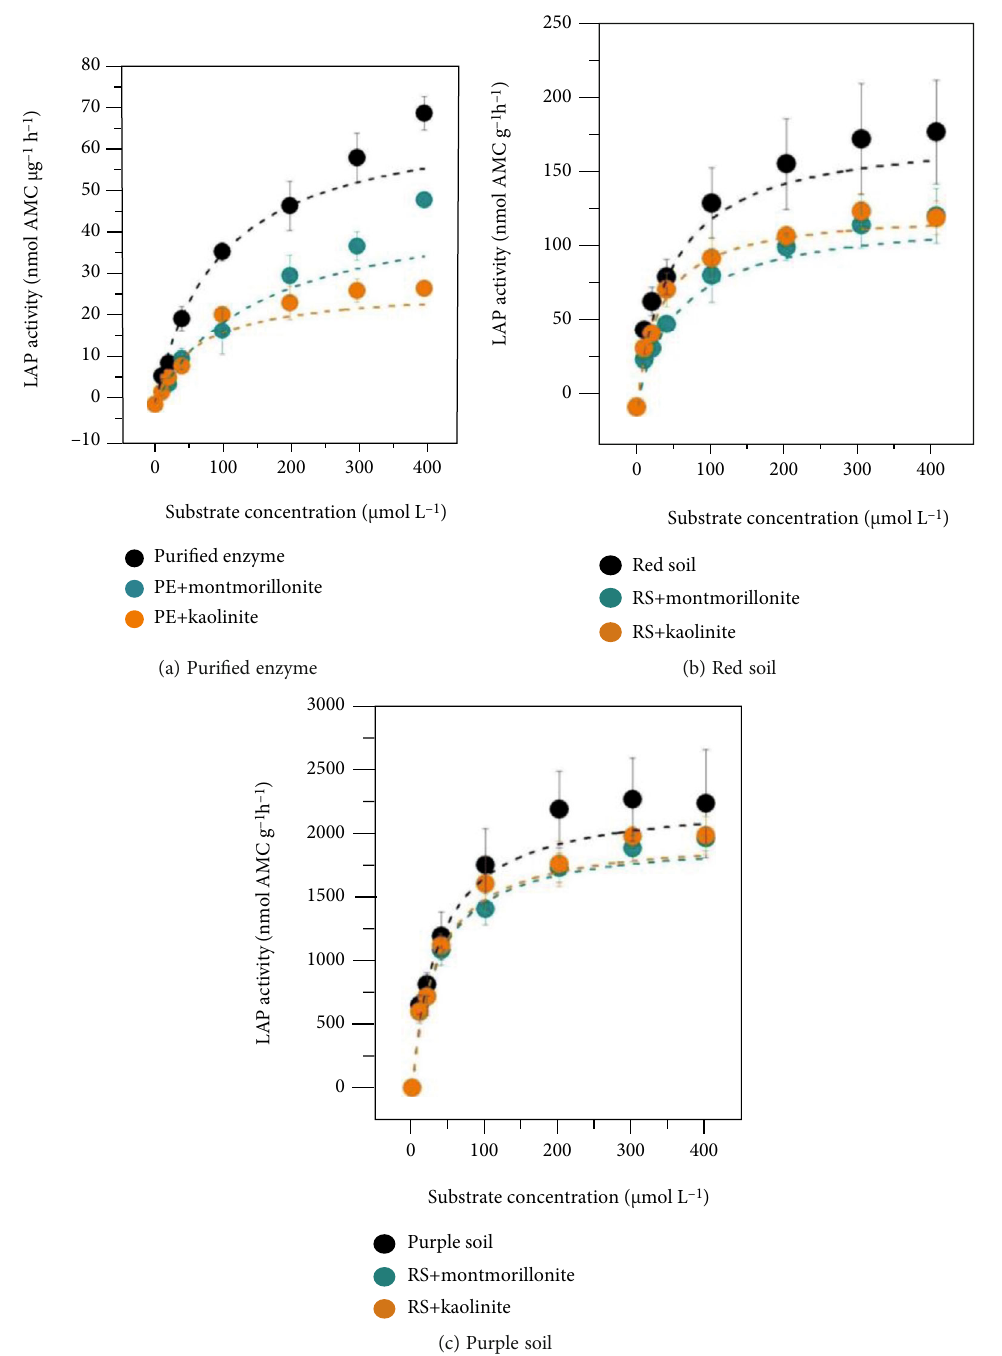
Figure 7: E ff ect of montmorillonite and kaolinite on the kinetic curves of puri fi ed LAP, LAP in red soil, and LAP in purple soil in the presence of 10 μ mol L -1